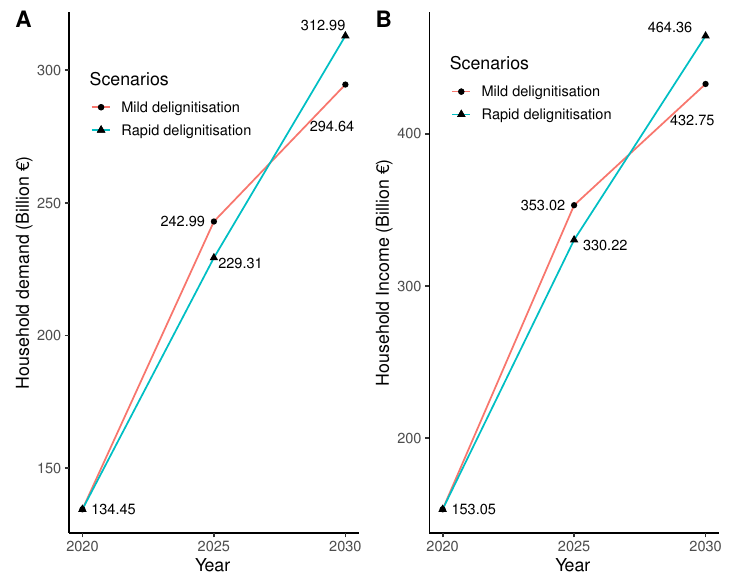
Figure 2. Graphical display of the household demand (plot A ) and income (plot B ) over the 2020–2025 and 2026–2030 periods under the mild and rapid delignitization